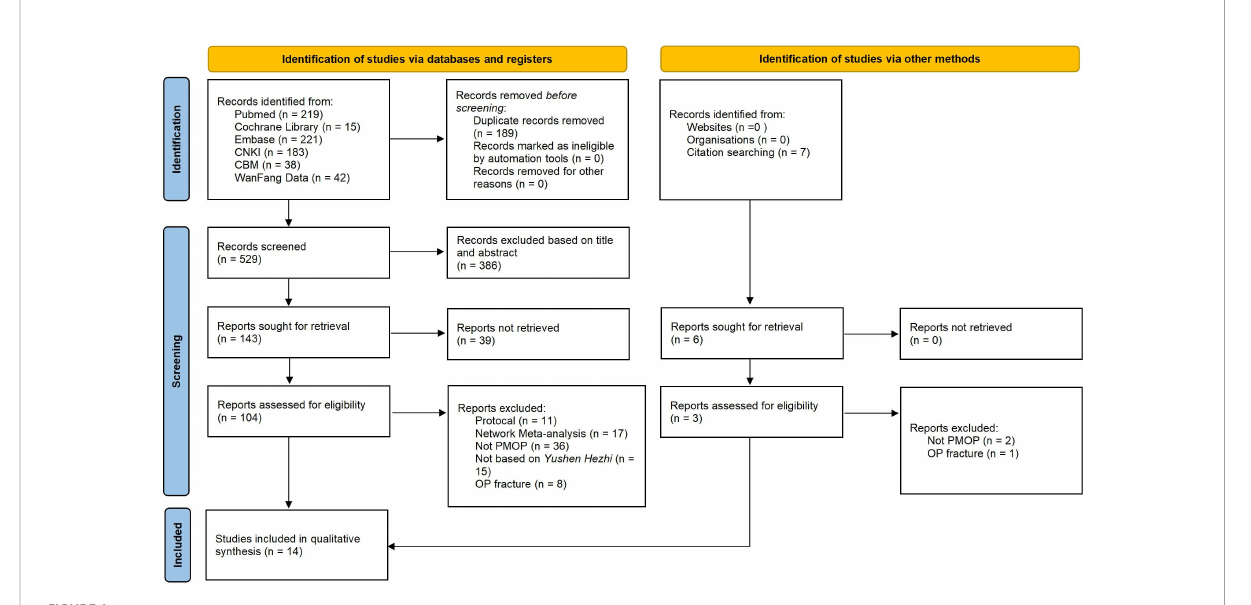
FIGURE 1 Flow diagram of literature screen